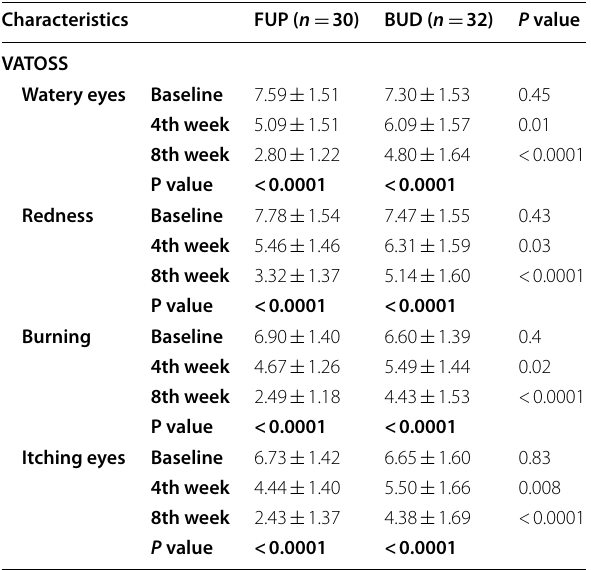
Table 3 Efficacy outcomes of visual analogue total ocular symptom